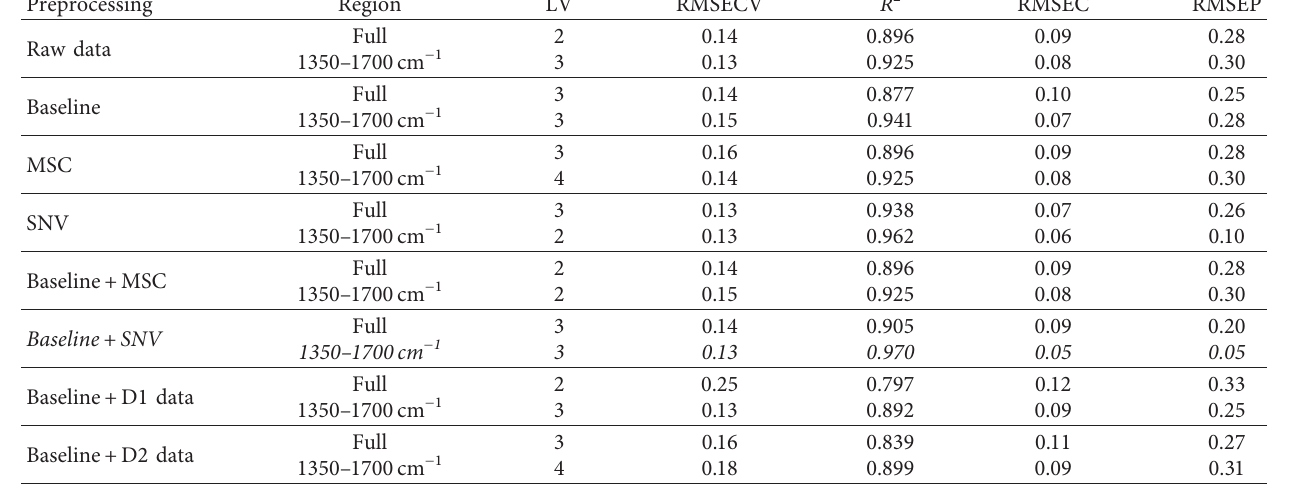
Table 3: Performance of the regression models using raw Raman data of calibration set samples and validation set samples which were obtained by randomly divided the calibration samples.